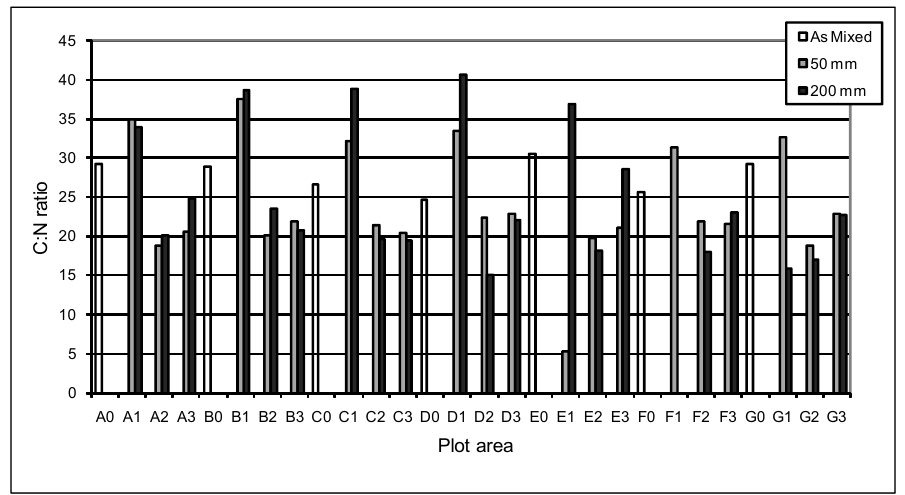
Refer to Fig. 10b for trial plot description Fig. 12. Carbon/nitrogen ratio for Car